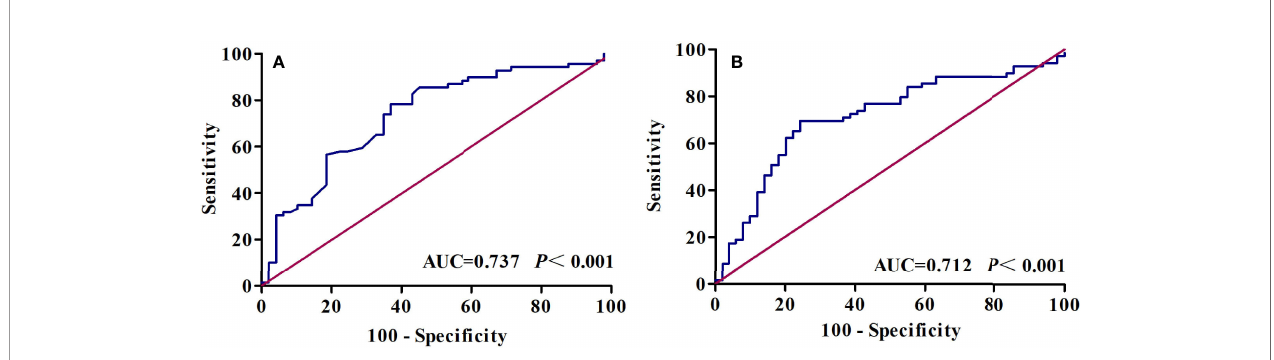
FIGURE 4 | Receiver operating characteristic (ROC) curve analysis of (A) Cho/Cr and (B) SII. Cho, choline; Cr, creatine; SII, systemic immune-in fl ammation